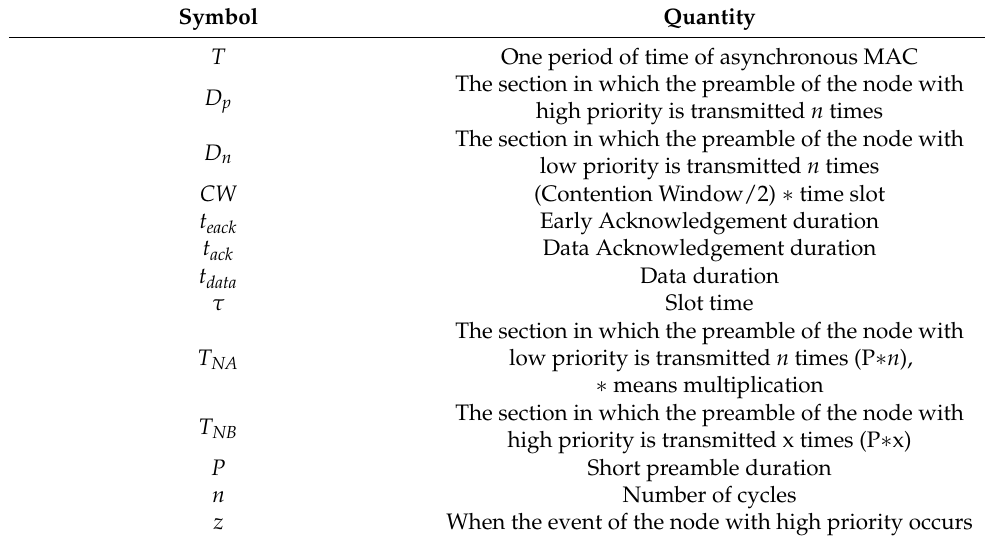
Table 2. Duty Cycle Pre-emption MAC Protocol